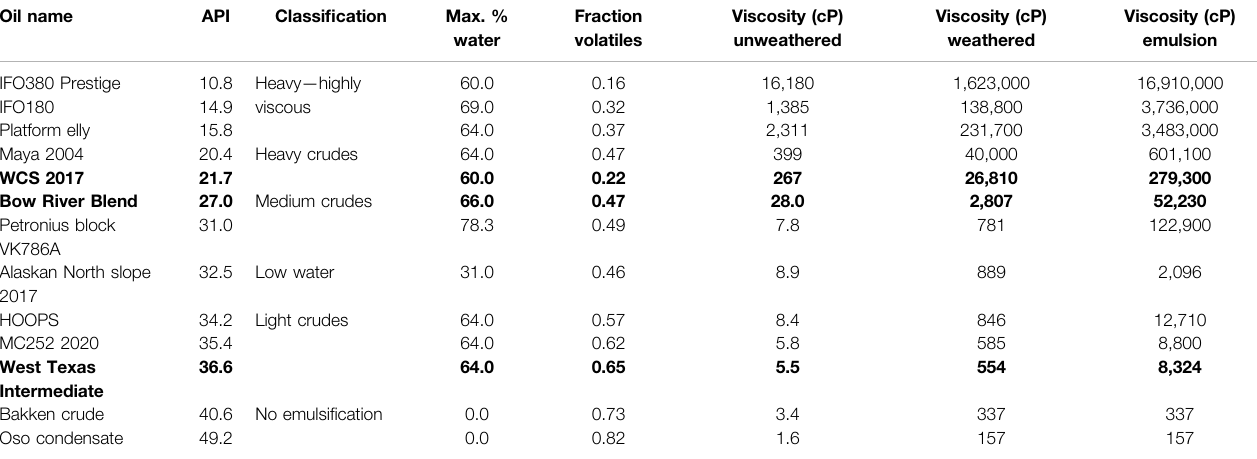
TABLE 2 | Viscosity at 20 ° C for non-weathered, fully weathered a non-emulsi fi ed, and fully emulsi fi ed as well as fully weathered oils. (The classi fi cation and associated colors indicate oils of similar expected behavior). Oil